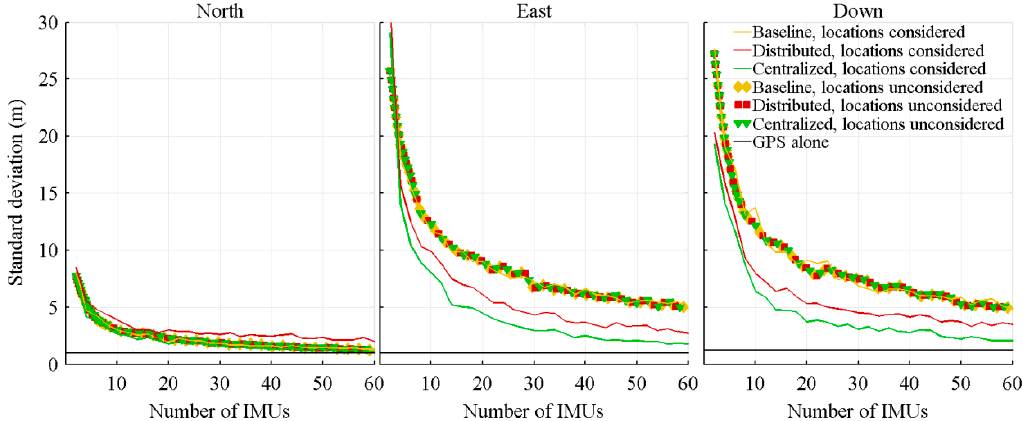
Figure 9. Standard deviation of the position errors when the projectile hits the ground, with respect to the number of IMUs.